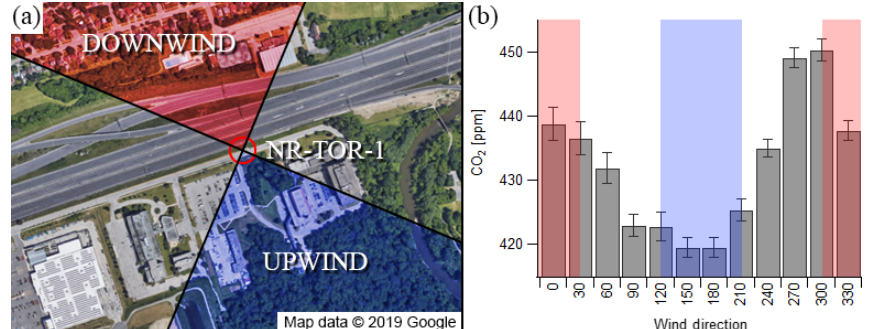
Figure 1. Satellite image of the NR-TOR-1 site, along with upwind (blue) and downwind (red) quadrant definitions. Meteorological mea- surements were taken on top of a 10m mast at the location of the station (labelled: NR-TOR-1) (a) . Average ambient CO 2 concentrations by wind direction, with upwind and downwind definitions again highlighted in blue and red, respectively. Error bars are 95% confidence intervals on the mean (b) .